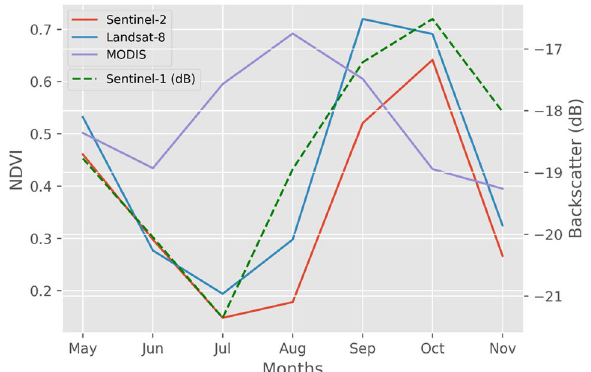
Figure 4. Average NDVI temporal profile for rice using Sentinel-2, Landsat-8 and MODIS derived NDVI data and average Sentinel-1 backscatter coefficient (dB) temporal profile for rice.